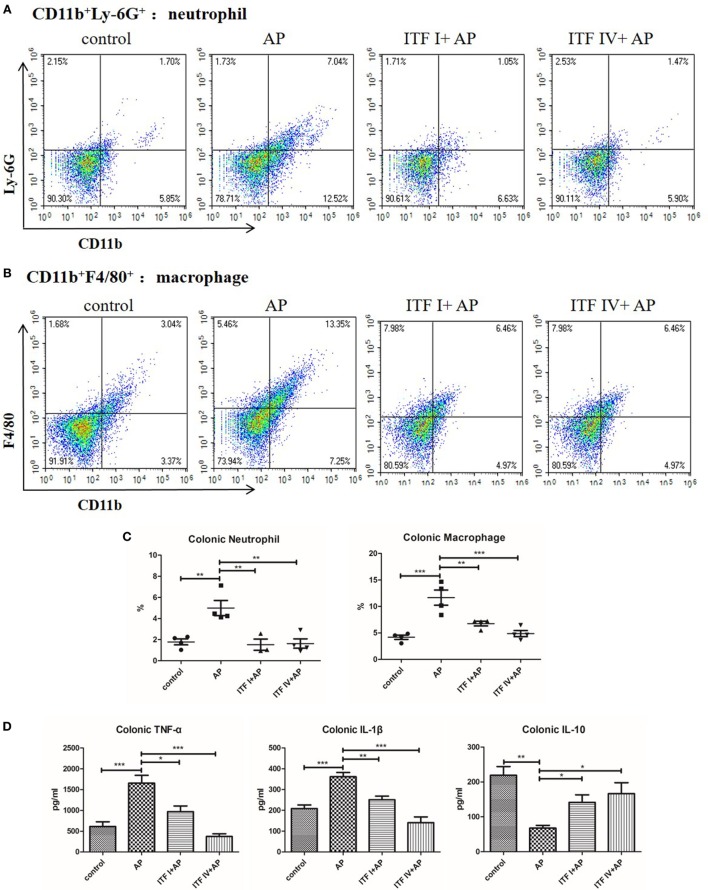
Effects of ITFs on neutrophil and macrophage infiltration and cytokine production in the colon. Mice were fed with 5% ITF I or ITF IV supplemented diets for 72 h before AP induction by caerulein. Neutrophil and macrophage infiltration and cytokine production in the colon were determined as described in Section “Materials and Methods,” respectively. Representative graphs showed dot plots of Ly-6G+CD11b+ neutrophils (A) and F4/80+CD11b+ macrophages (B) in the pancreas and quantitative analysis of neutrophils and macrophages infiltration in the colon (C). Quantitative analyses of TNF-α, IL-1β, and IL-10 levels in the colon were performed by ELISA (D). Data shown are means ± SEM. *P < 0.05, **P < 0.01, and ***P < 0.001. AP, acute pancreatitis; ELISA, enzyme-linked immunosorbent assay; IL, interleukin; ITF, inulin-type fructans; TNF-α, tumor necrosis factor-α.